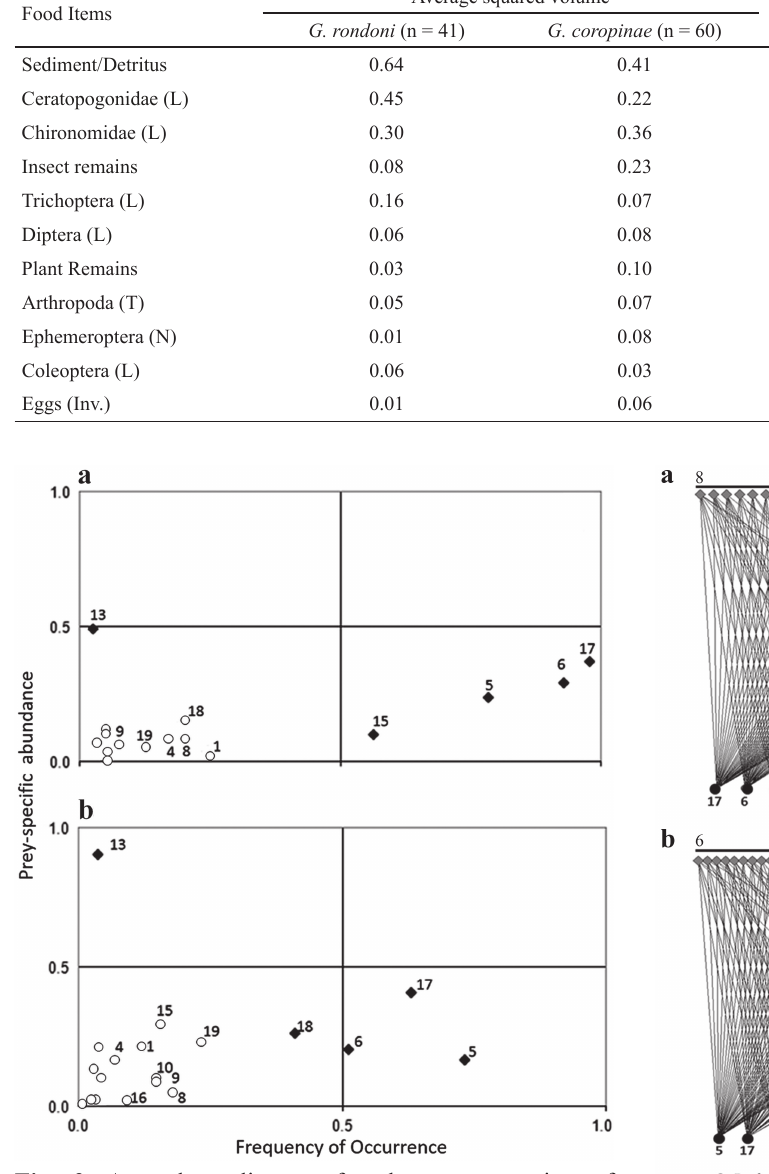
Fig. 3. Amundsen diagram for the representation of feeding strategies of Gymnorhamphichthys rondoni and Gymnotus coropinae in first to third order streams at the Saracá-Taquera National Forest, Oriximiná, Pará. Rare items are shown in empty squares. a. G. rondoni ; b. G. coropinae . Codes: 1 - Arthropoda (T); 2 - Algae;